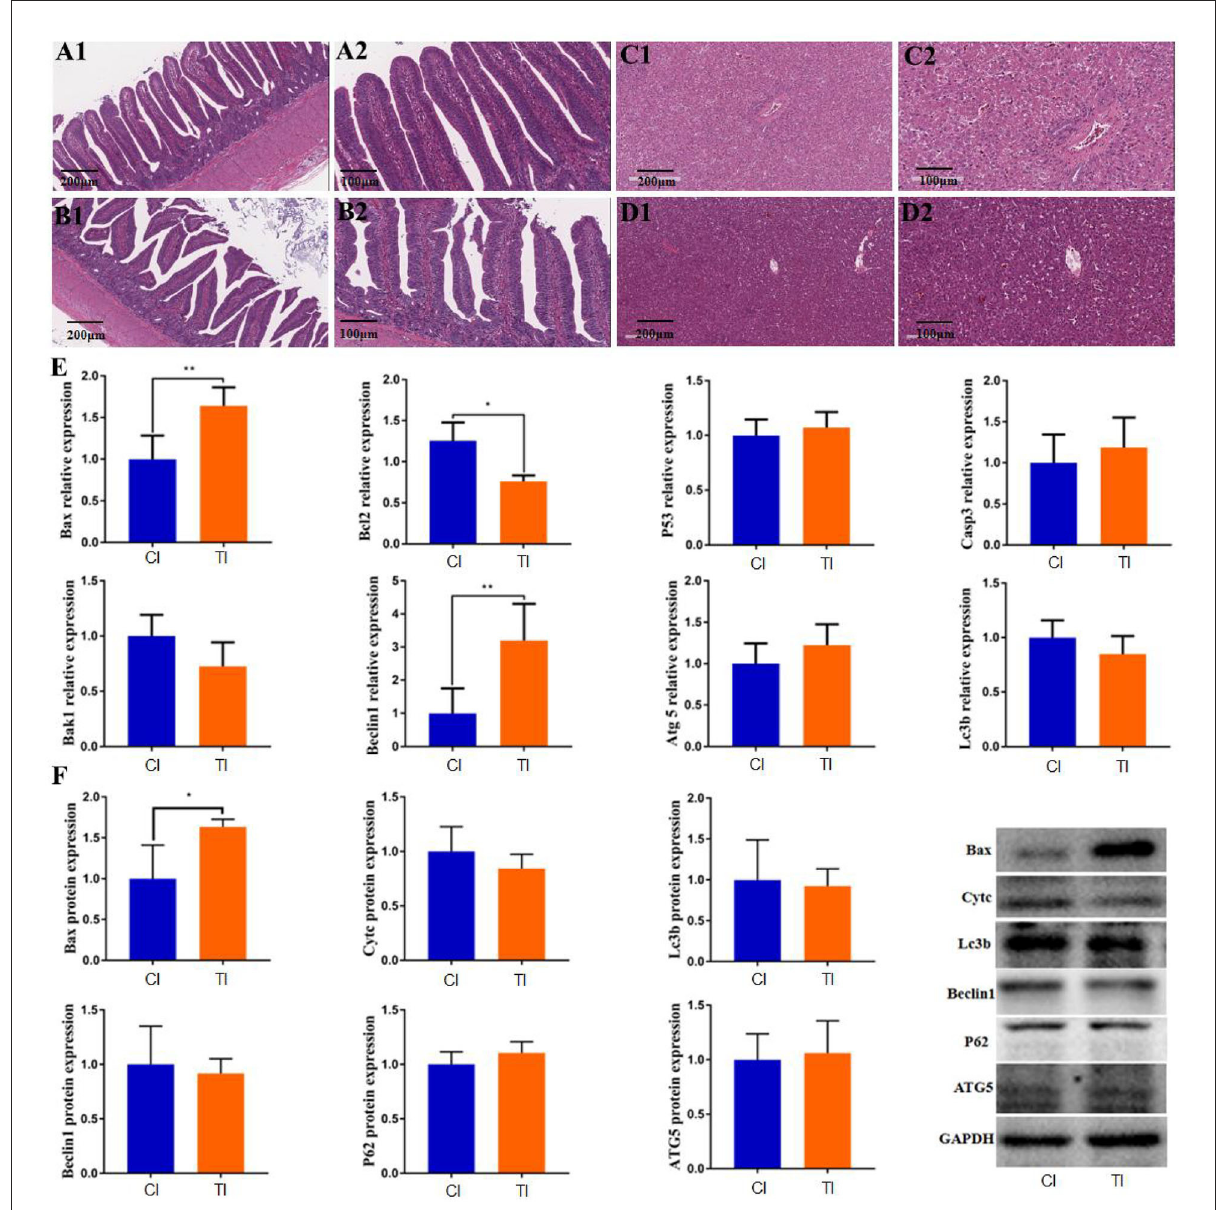
FIGURE1 Thiram exposure caused intestinal and liver injury. (A1,A2,B1,B2) Histopathological observation in intestinal tissues of the control group and thiram-treated group. (C1,C2,D1,D2) Histopathological observation in liver tissues of the control group and thiram-treated group. (E) Changes in gene expression related to liver apoptosis and autophagy. (F) Changes in protein expression related to liver apoptosis and